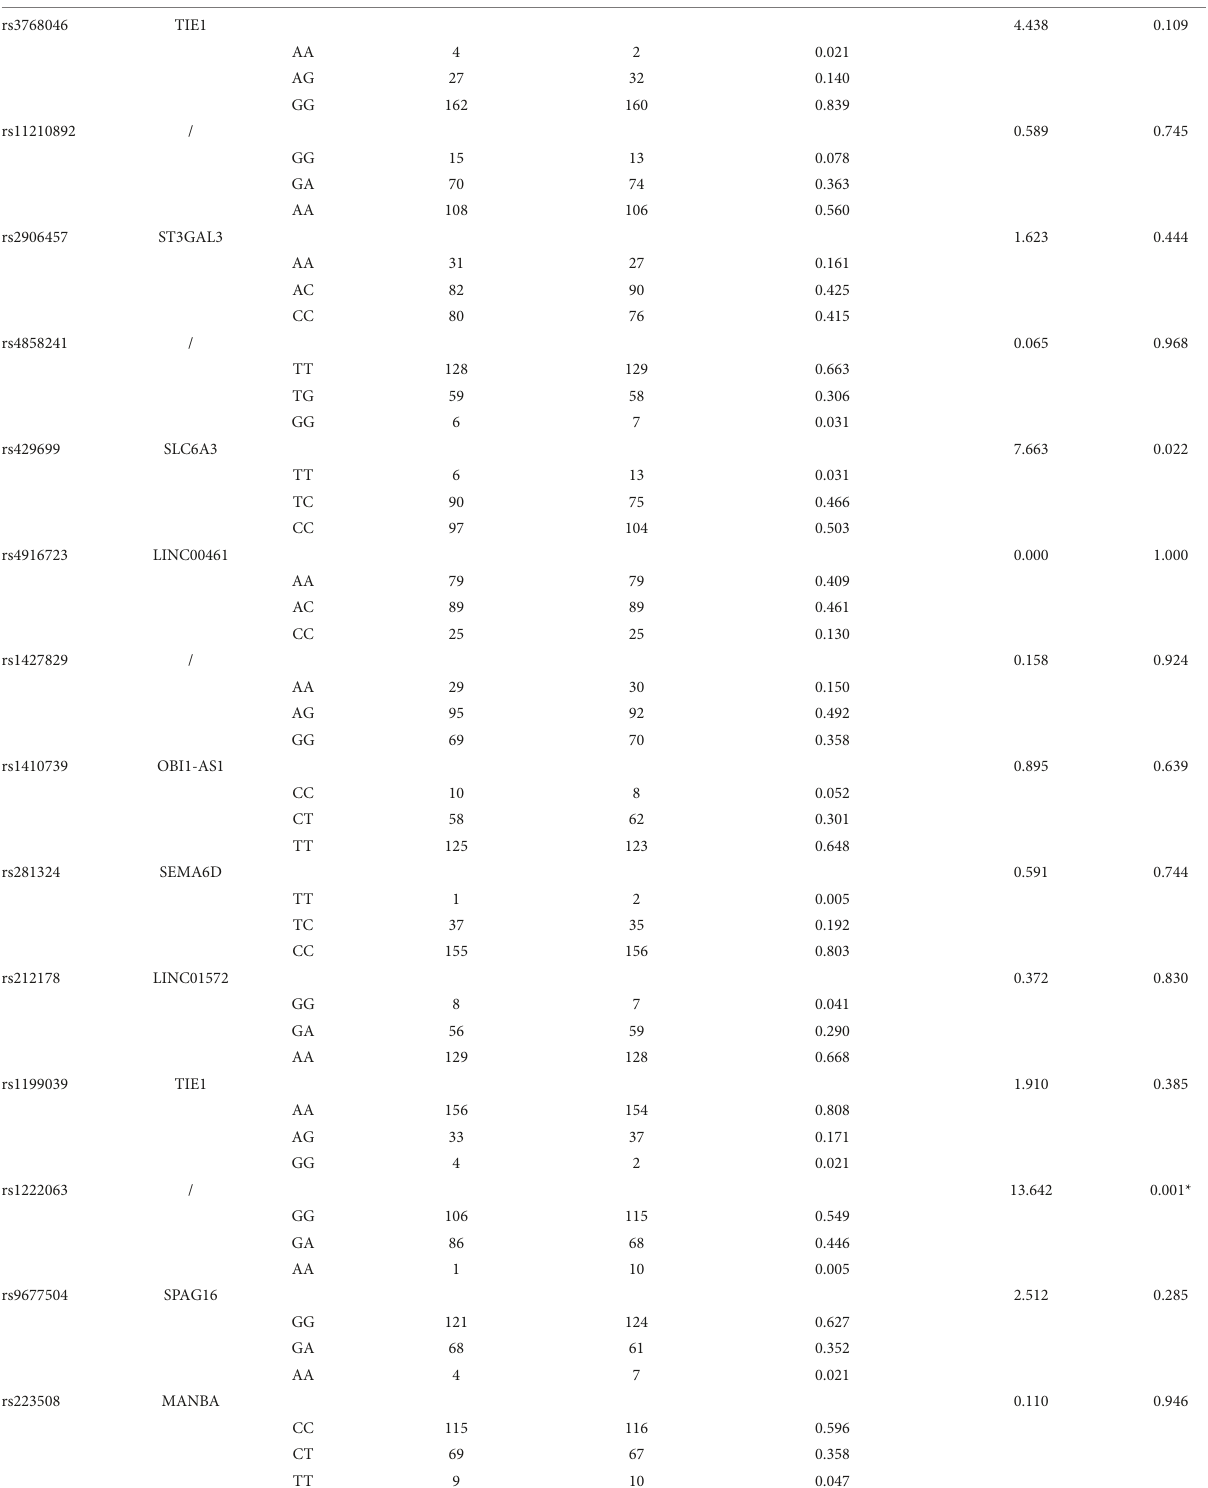
TABLE 1 Coincidence test of Hardy–Weinberg equilibrium of 17 attention deficit hyperactivity disorder (ADHD)-related loci in 193 children with ADHD. Index